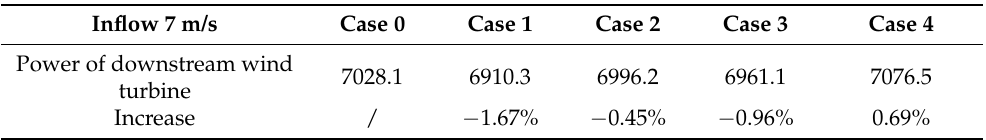
Table 6. Comparison of the power of downstream large wind turbines under different wind tunnel test cases (unit: